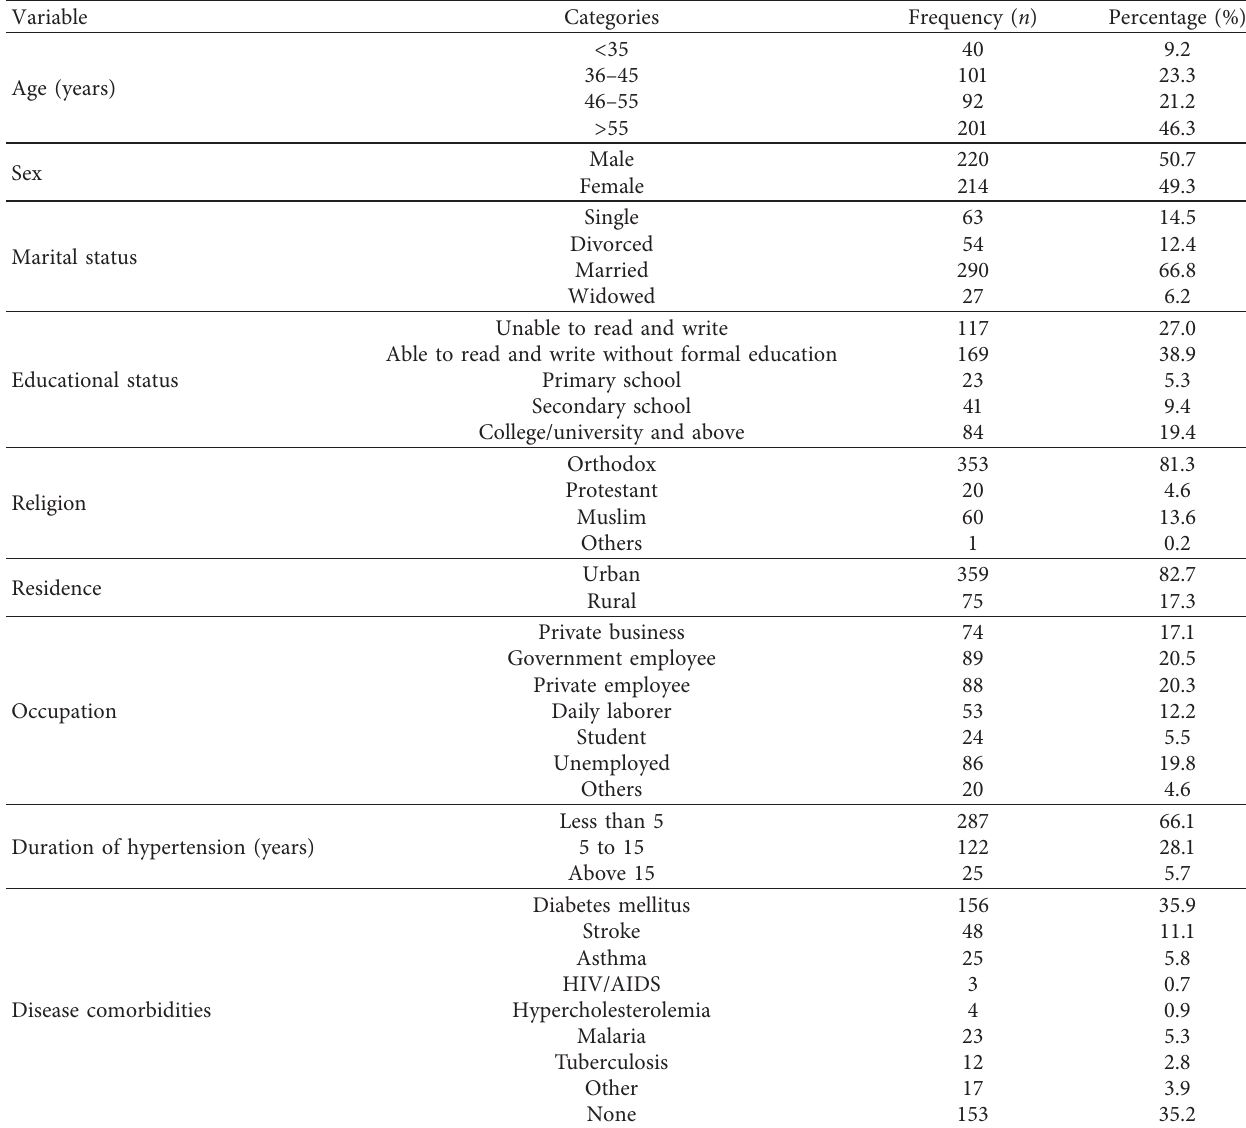
Table 1: Sociodemographic characteristics of the study participants at Gondar town in 2019.